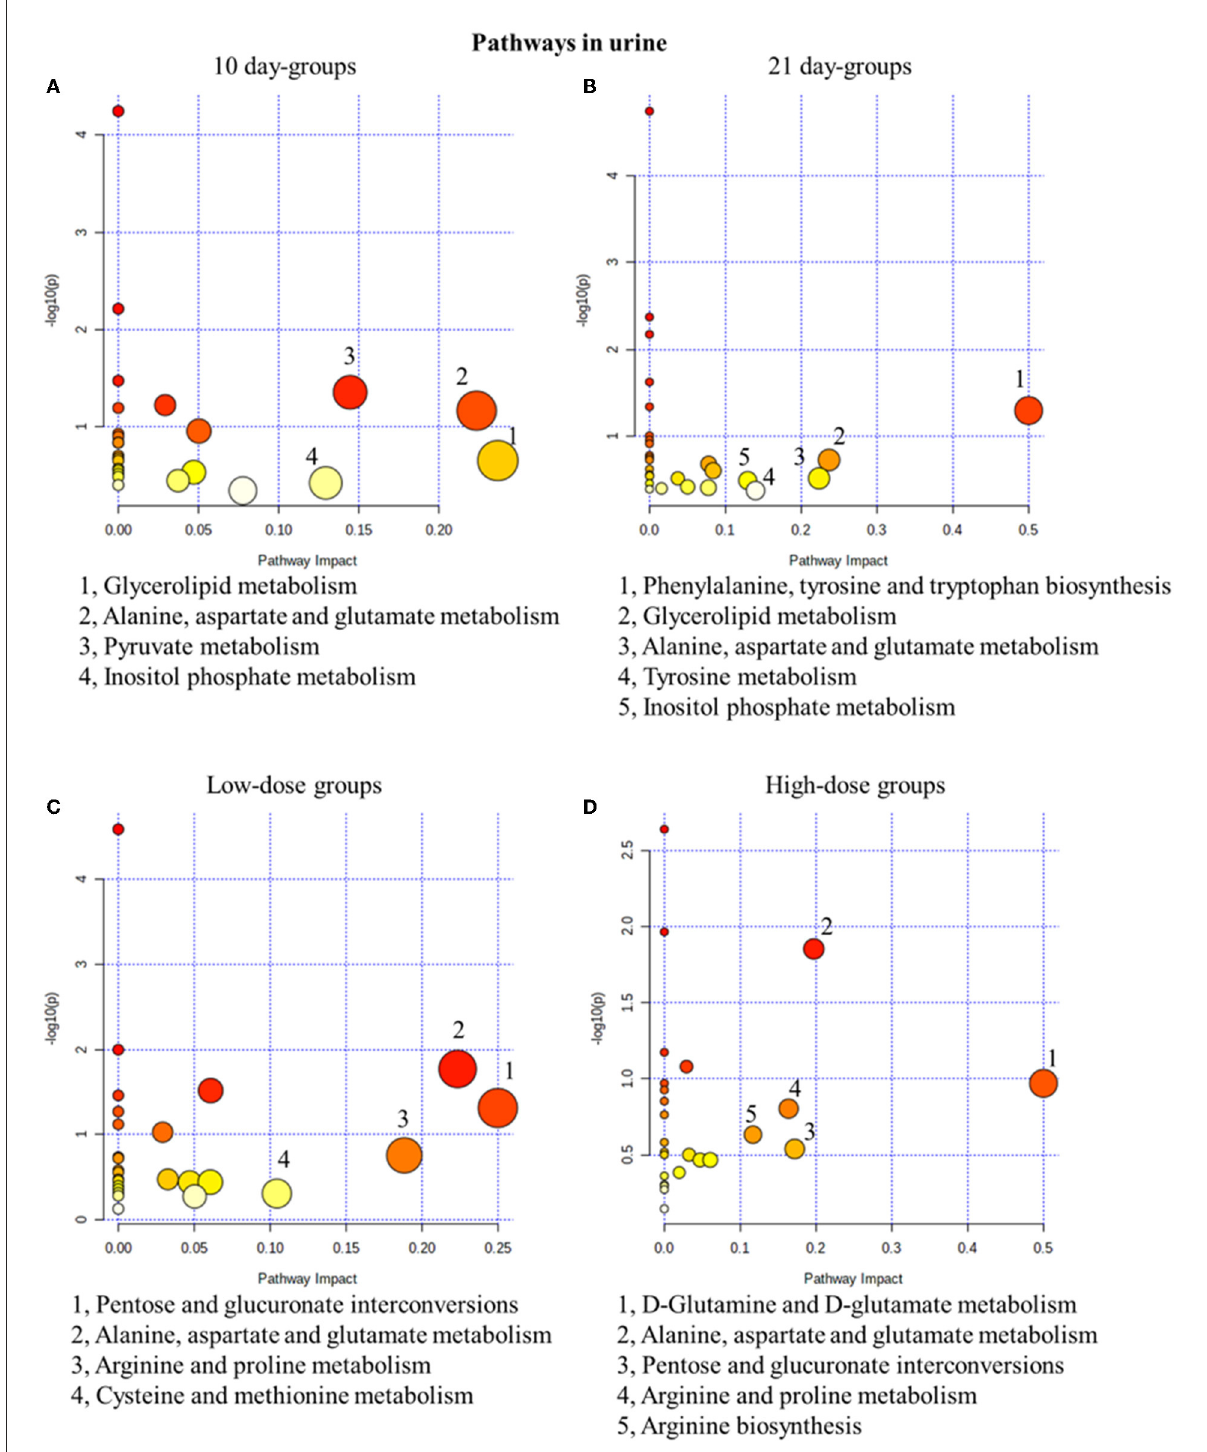
FIGURE4 Metabolic pathway analysis of urine samples with different groups. (A) pathways of low-dose and high-dose groups on the 10th day. (B) pathways of low-dose and high-dose groups on the 21th day. (C) pathways on the 10th day and 21st day of low-dose groups. (D) pathways on the 10th day and 21st day of high-dose